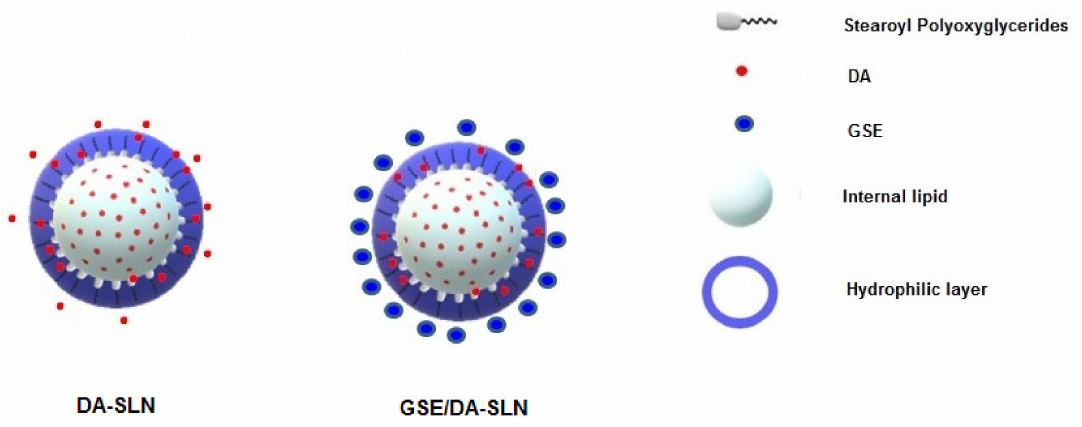
Figure 8. Schematic representation of SLN herein